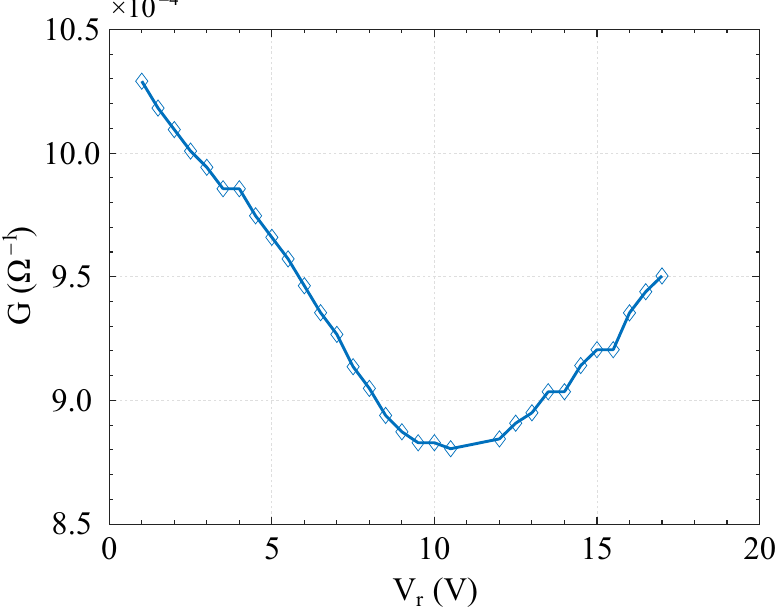
Figure 13. Values of filter conductance G ( V r ) shown via the equivalent circuit model as functions of control voltage V r